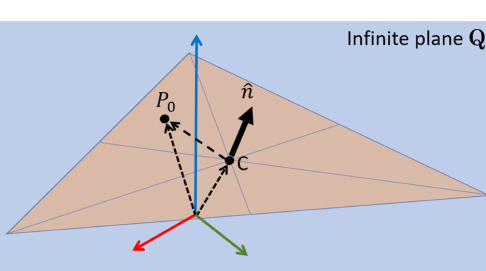
Figure A2. The infinite plane defined by its scalar